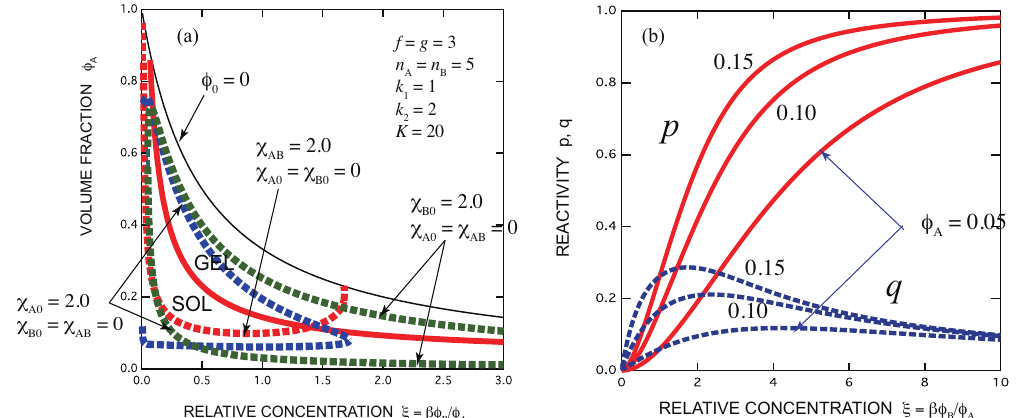
Figure 5. ( a ) Phase diagram of a mononuclear A cross-link junction; f = g = 3, ( k 1 , k 2 ) = ( 1,2 ) . The gel region is bound ) from above. SGST line (red line), spinodals for χ = 2.0 (red broken by ξ min = 0 from below and ξ max = g (cid:48) ( f (cid:48) k 2 + k (cid:48) A , B 2 line), for χ A ,0 = 2.0 (blue broken line), and for χ B ,0 = 2.0 (green broken line) are shown. For the repulsive interaction χ A , B = 2.0 in a good solvent χ A ,0 = χ B ,0 = 0, phase separation takes place before the solution gels when the concentration of added B molecules is increased. ( b ) Reactivity p (solid lines) and q (broken lines) shown as functions of the scaled B concentration for three fixed A concentrations. They all start from 0. The reactivity of B groups shows a maximum near the stoichiometric